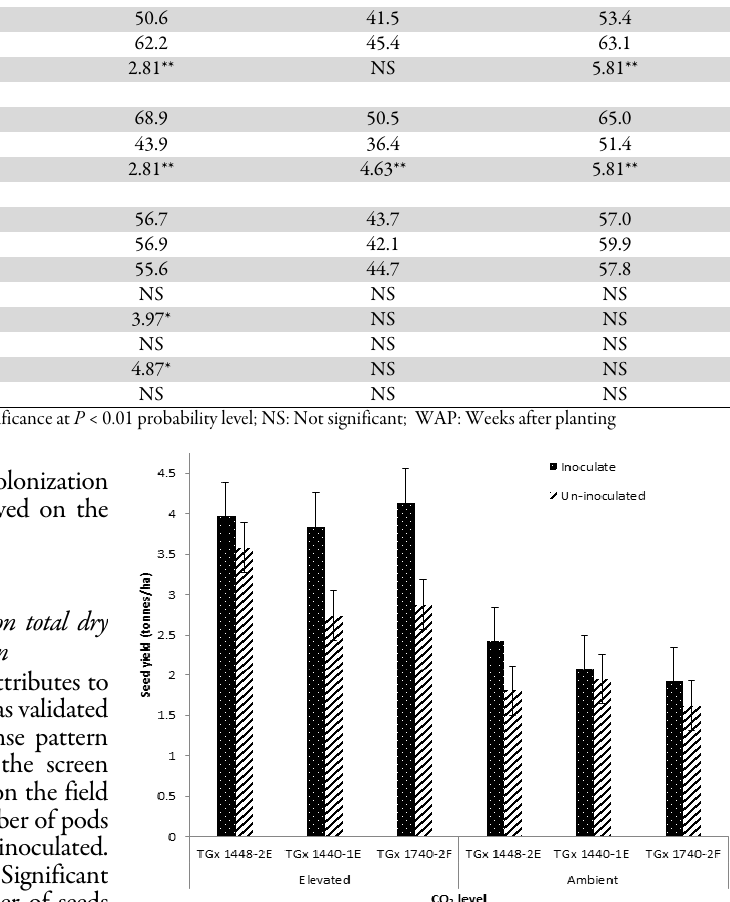
Fig. 3. Interaction of CO elevation × AMF inoculation × 2 variety on seed yield. Bars in each column indicate standard error of mean (±SE). (Field